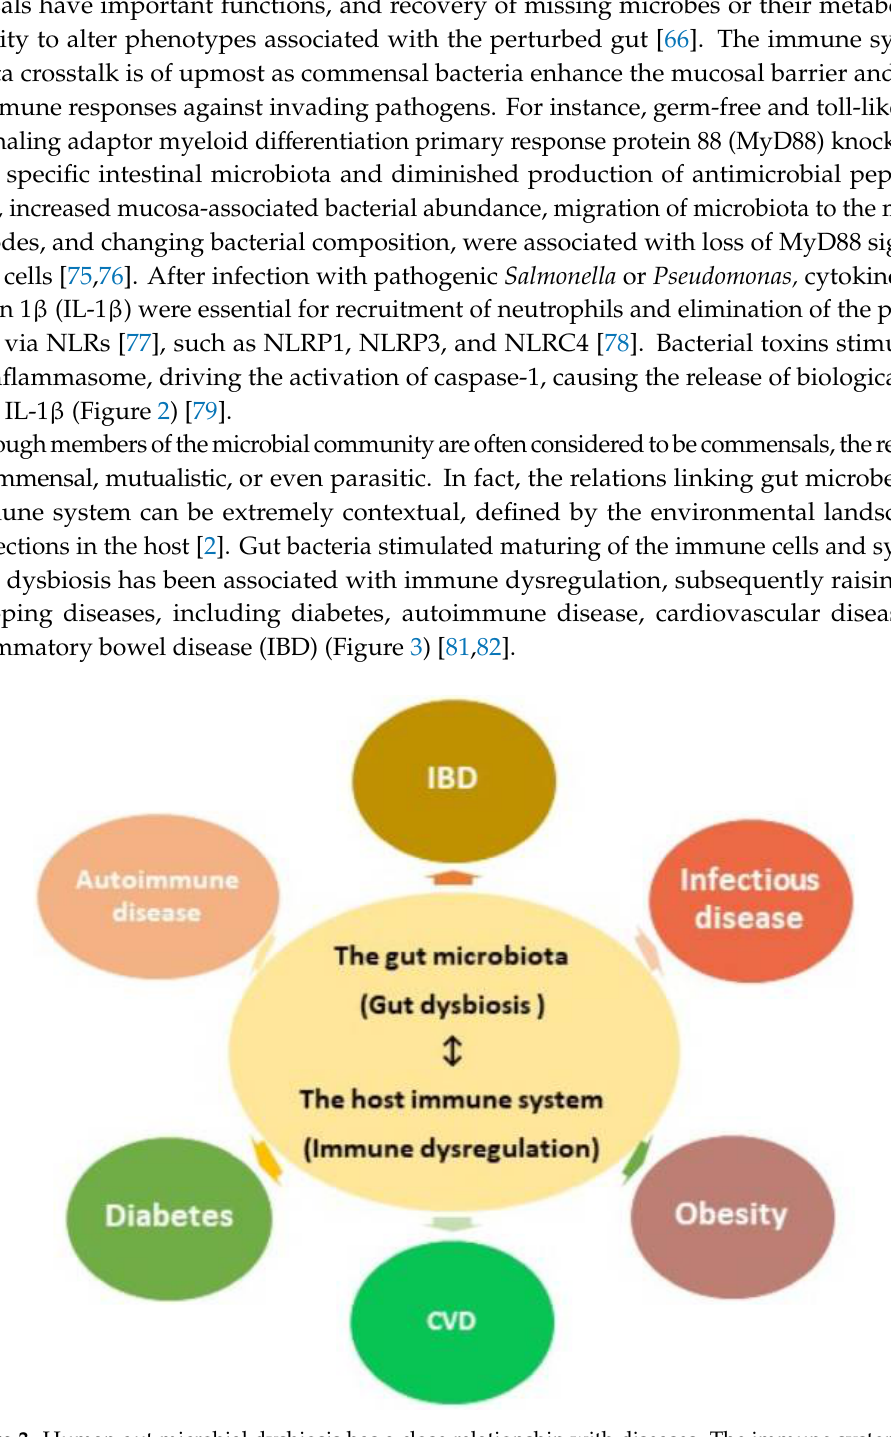
Figure 3. Human gut microbial dysbiosis has a close relationship with diseases. The immune system–gut microbiota crosstalk is of sublime significance in understanding the role of dysbiosis-driven diseases in humans. Gut dysbiosis induces immune dysregulation and subsequently increase the risk of developing diseases, such as diabetes, obesity, cardiovascular disease (CVD), infectious disease, inflammatory bowel disease (IBD), and autoimmune disease. Diversity and abundance of gut microbiota were established as vital determinants of host health, and changes in diversity have been identified with a variety of diseases in humans. Whether the microbiota contributes directly to the etiology of all associated diseases remains unknown. However, many studies have shown that gut bacteria are directly involved in the onset and progression of specific diseases through a complex network linking metabolism and host immune systems [83–85]. The association between gut dysbiosis and mucosal inflammation might be a cause of dysbiosis, its consequence, or perhaps both acting in tandem. Gut bacteria were strongly related to the onset and progression of inflammation in the mucosal layers of germ-free mice [86]. One common cause of gut dysbiosis, observed in both clinical and animal models, is infection. Infectious diseases and their treatments influence the human gut microbiota, creating feedback loops which alter the local environment and ultimately determine the effect of the infection on the host microbes. Many studies have verified the close connections linking infection and gut dysbiosis and have demonstrated relationships with both gut bacteria and resident viruses [87]. For example, Clostridium difficile infection patients had gut microbiota that were significantly altered in a manner that promoted the progression of the hepatitis B virus (HBV), the human immunodeficiency virus (HIV), and other infectious diseases [35,88]. 3. Dysbiosis of the Gut Microbiota and Related Diseases The mucosal barrier secreted by gut epithelial cells acts as a defense mechanism, segregating microbes from host immune cells and reducing intestinal permeability. Disrupting the epithelial barrier increases susceptibility to infection and the displacement of microbial metabolites into the